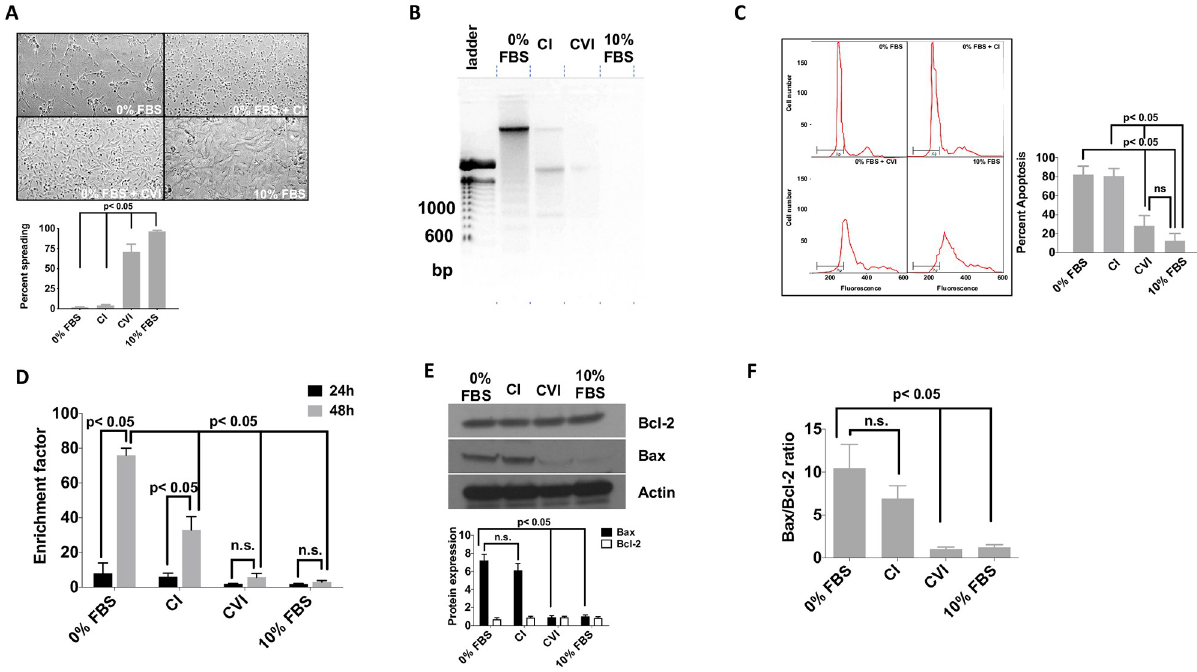
Fig 1. Soluble CVI induces HSC spreading and prevents apoptosis. ( A ) Primary rat HSC from the third passage were cultured 24 h in 6-well plates in serum-free medium, standard medium containing 10% FBS, or in serum-free medium supplemented with 30 μ g/ml CI and 30 μ g/ml CVI. Shown are representative images at 40-fold magnification from one out of three independent experiments. Graph below shows the quantification of spreading from three independent experiments. ( B ) 10 6 serum-starved primary rat HSC were cultured for 24 h in medium alone, CI, CVI or 10% FBS. DNA was extracted and subjected to agarose gel electrophoresis to detect apoptosis-associated DNA laddering. Shown is a representative experiment out of three experiments. ( C ) Serum-starved activated HSC were grown in serum-free medium, CI, CVI or 10% FBS for 48 h. After fixation in 70% ethanol and RNase digestion, cellular DNA was stained with propidium iodide and subjected to FACS analysis. The integrated area of cellular DNA content was calculated as percentage of apoptotic cells. Right graph depicts quantification of apoptosis in each group from three independent experiments. ( D ) HSC were cultured for 24 or 48 hours and analyzed for the abundance low molecular weight oligonucleosomal DNA indicative of apoptosis by a sandwich ELISA. Shown are results of three independent experiments. ( E&F ) Expression levels of Bax and Bcl-2 was determined in activated HSCs by western blotting after 24 hours cultured in 0% FBS alone or in the presence of CVI and CI or 10% FBS. Shown is a representative blot from three independent experiments; densitometric analysis is derived from three independent experiments and ratio of Bax to Bcl-2 is shown. Statistics were calculated by one- way ANOVA analysis and Tukey’s multiple comparisons test. Differences p < 0.05 were considered